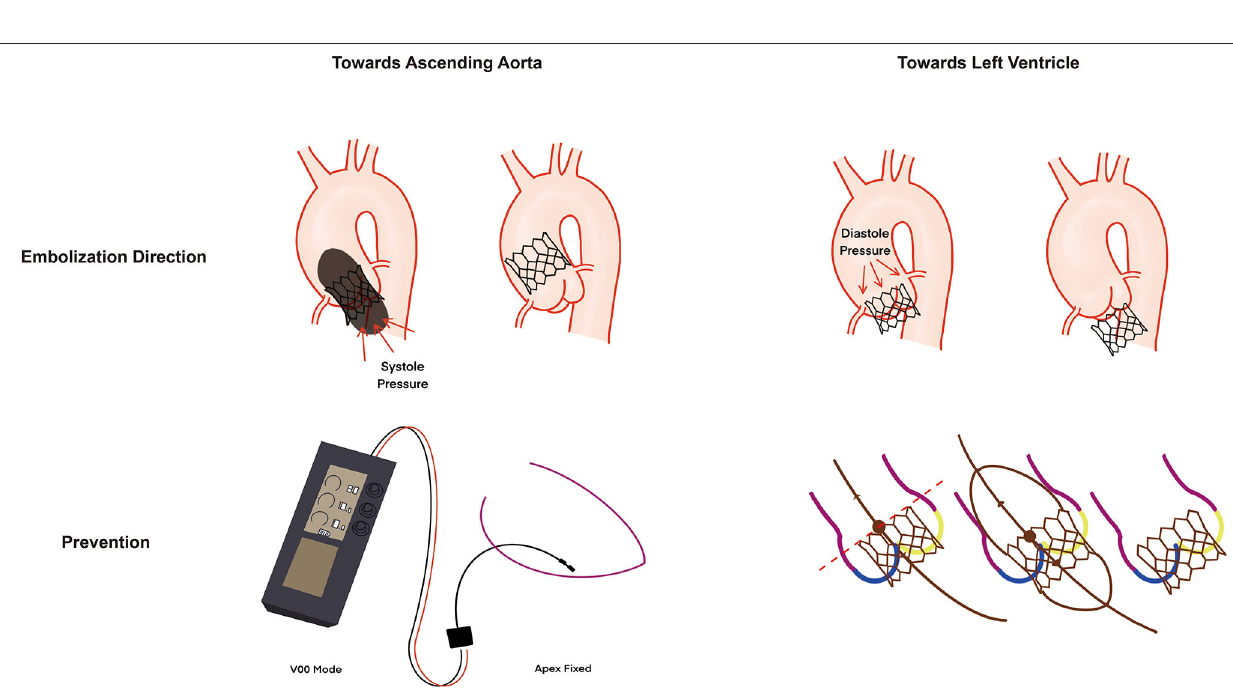
FIGURE 4 | Mechanism of BEV embolization and prevention. BEV can migrate toward ascending aorta (systole pressure caused by rapid pacing failure) or left ventricle (diastole pressure). Adequate assessment of rapid pacing before implantation with V00 mode and fixed apex position and sufficient anchor with the “flare the outflow” technique could enhance the anchor of BEV. BEV, balloon expandable